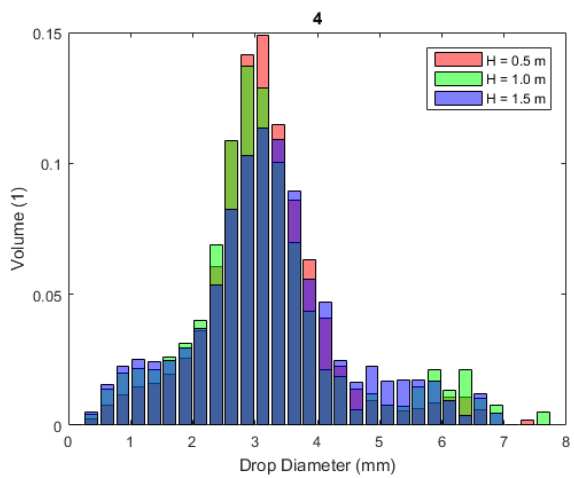
Fig. 12. Drop size histogram based on volume for the mean water flow rate 0.0002812 m 3 /s